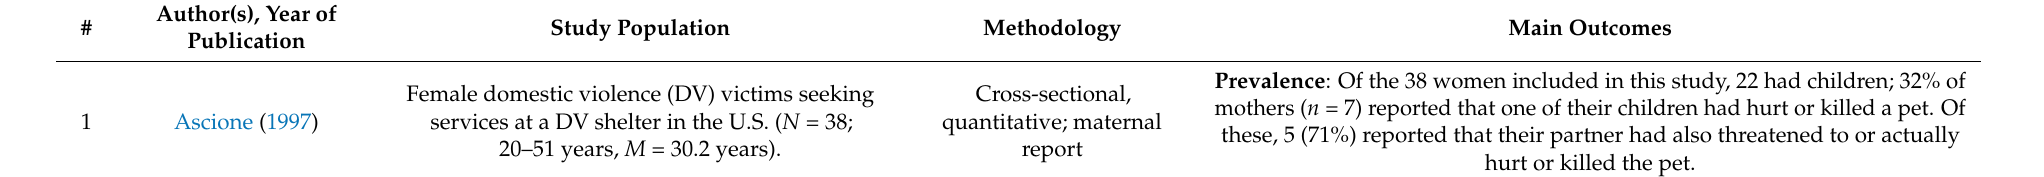
Table 4. Studies Included in the Scoping Review That Examined Intimate Partner Violence and Youth Engagement in Animal